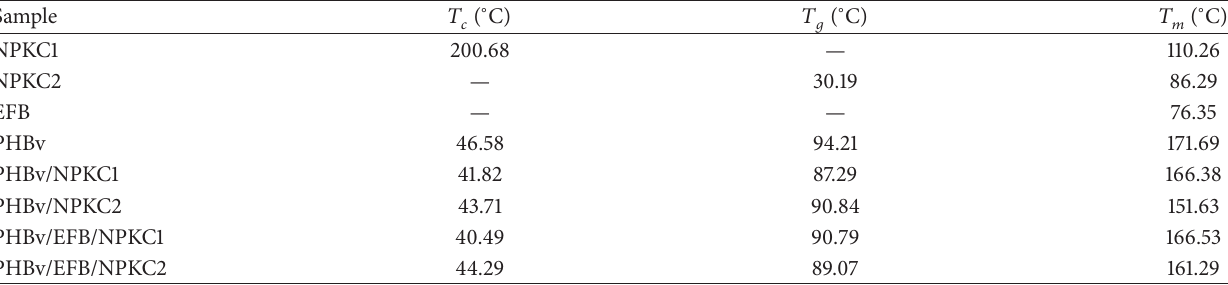
Table 3: DSC characterisation of pure PHBv, PHBv/NPK, and PHBv/NPK/EFB composites.